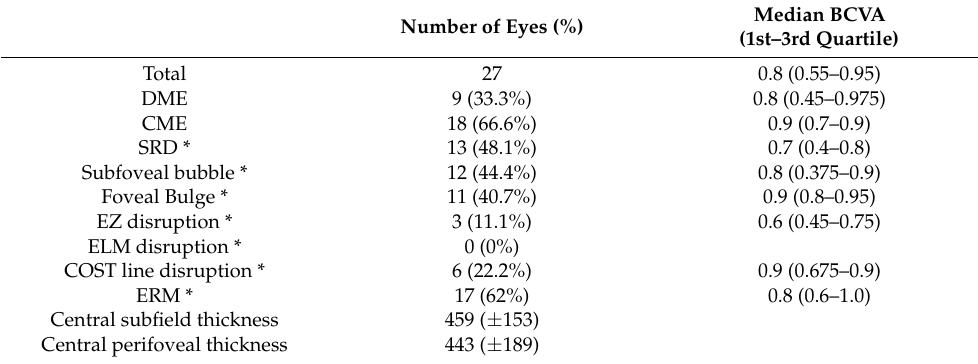
Table 1. Results of the morphological features on OCT with the corresponding BCVA. DME: diffuse macular edema, CME: cystoid macular edema, SRD: serous retinal detachment, COST: cone outer segment tip, EZ: inner segment/outer segment, ELM: external limiting membrane.